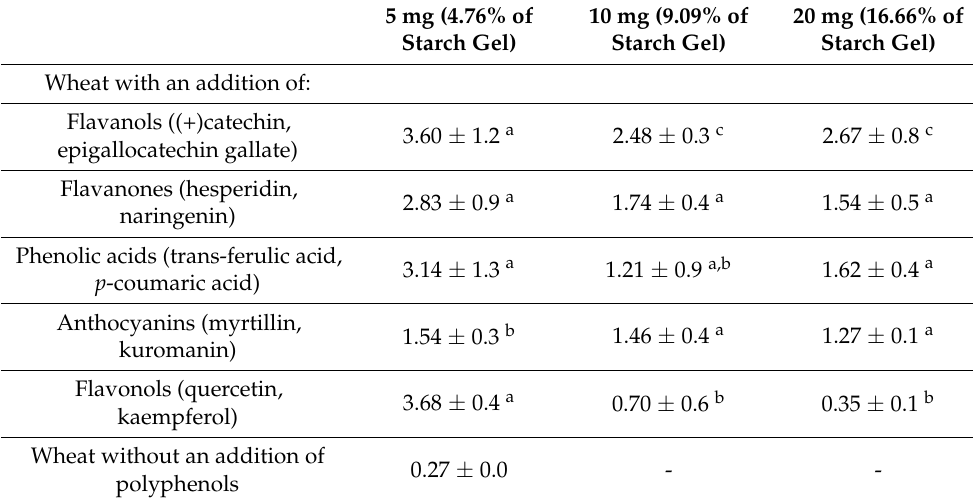
Table 2. Contents of RS in wheat starch (g · 100 g − 1 dm) depending on the type and dose of the polyphenol group standard